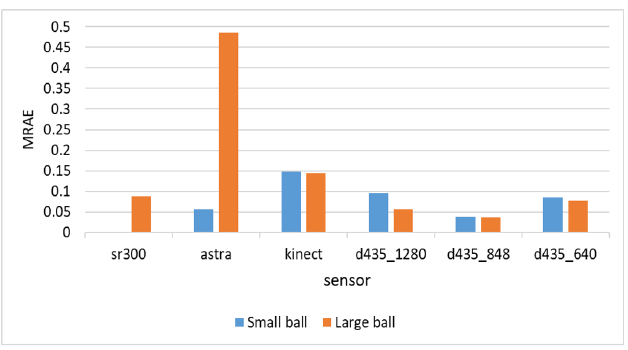
Figure 8. MRAE for diameter estimation of the two balls.